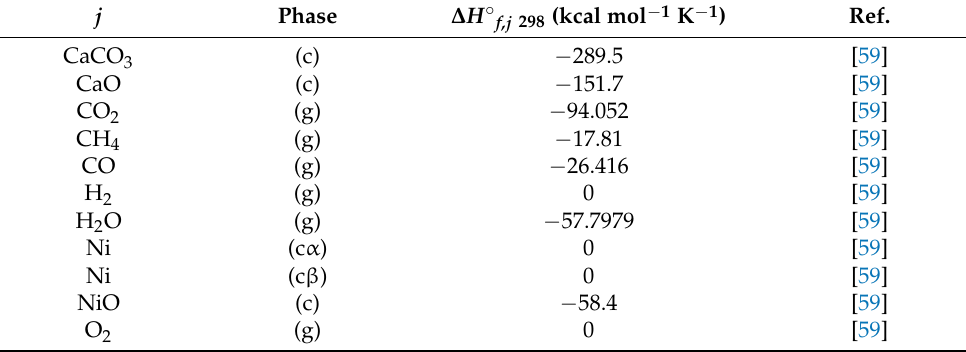
Table A2. Standard heats of formation ∆ H ◦ f,j 298 in (A4) (phases: (c) = crystalline; (g) =